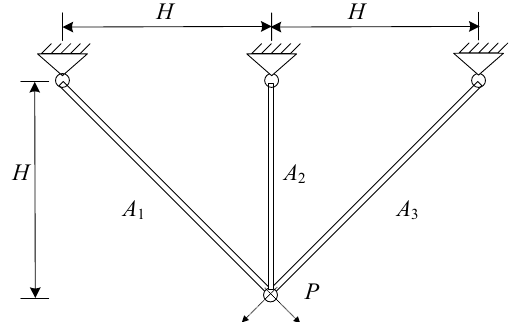
Figure 9. The three-bar truss design.